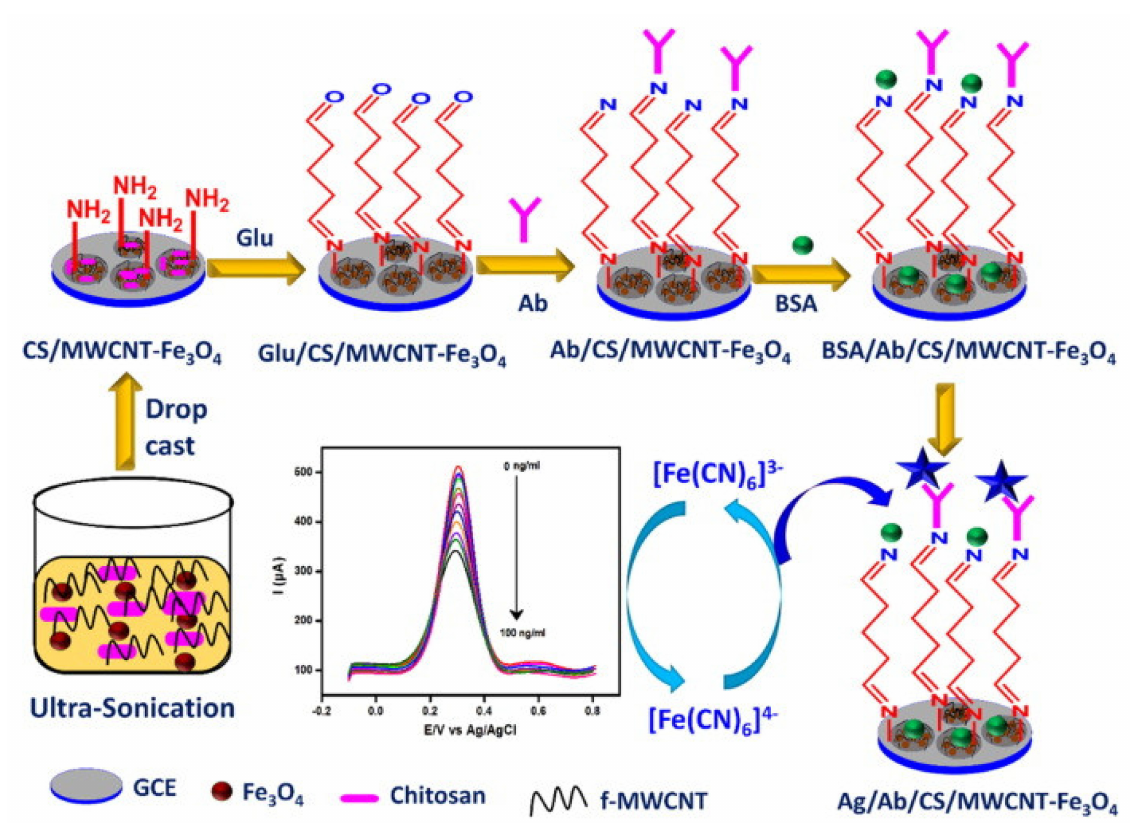
Figure 5. Schematic illustration of the fabrication process of CS–MWCNT–Fe 3 O 4 based immunosen- sor for electrochemical detection of CA19–9 antigen. CS: chitosan; MWCNT: multiwalled– carbon nanotube; Fe 3 O 4 : magnetite nanoparticles; Ab: antibody; Ag: antigen. Reprinted with